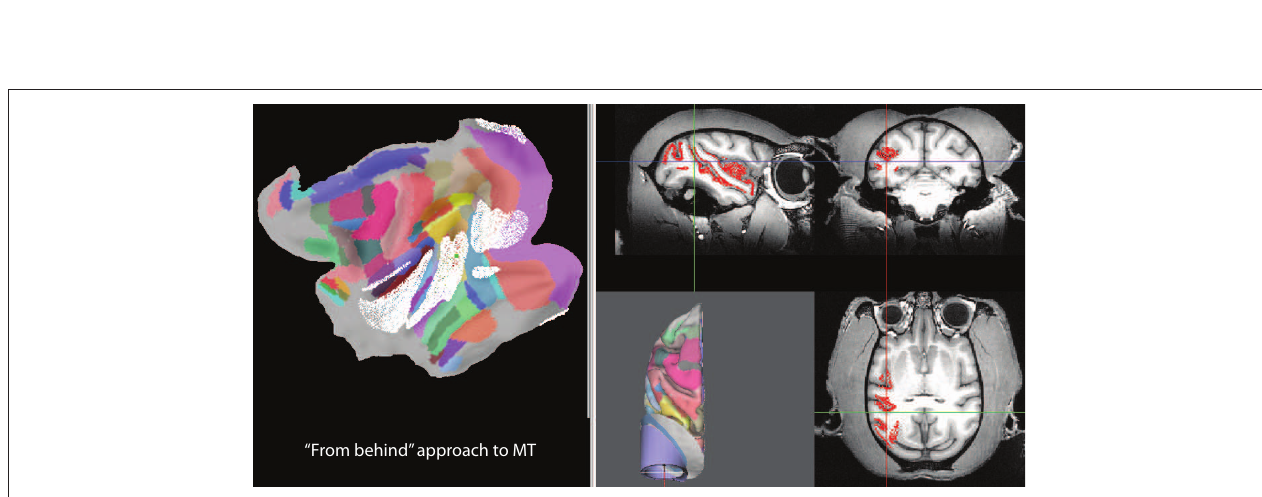
Figure 7 | Visualization of all parts of the brain that can be accessed with an approach “from behind” (symmetry axis parallel to sagittal plane and 20 ° above horizontal; elevation of − 70 ° and tilt of